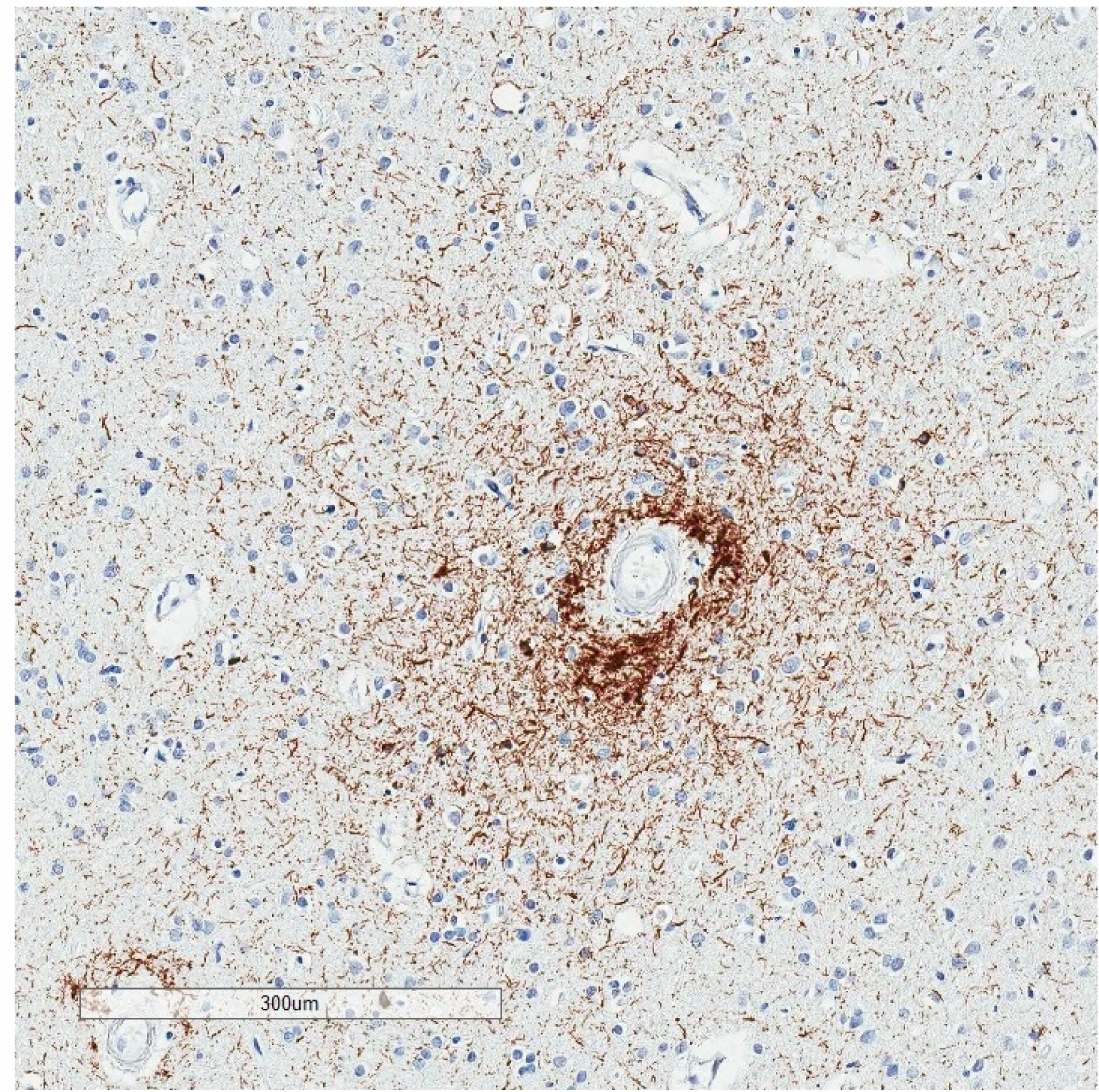
Figure 8. Irregular p-tau aggregates with “vasculocentric neurites” at a sulcal depth, consistent with the required criterion for CTE. The decedent was a 78 year old man with Parkinson’s disease and Alzheimer’s disease pathology. His traumatic brain injury and contact sport history are